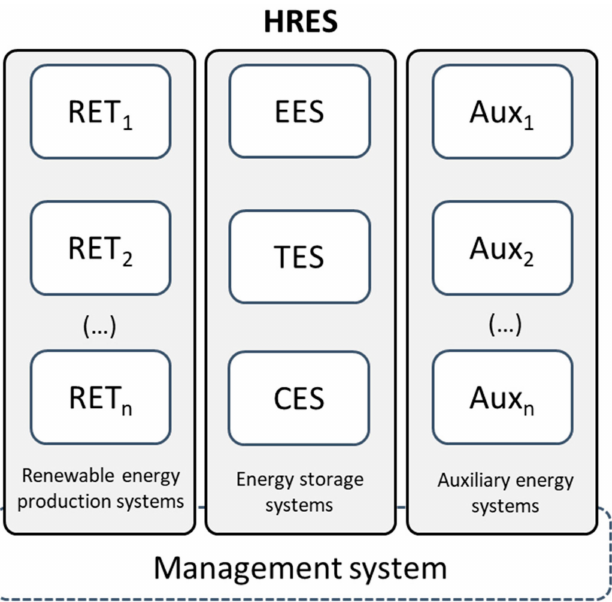
Figure 1. Qualitative schematization of a